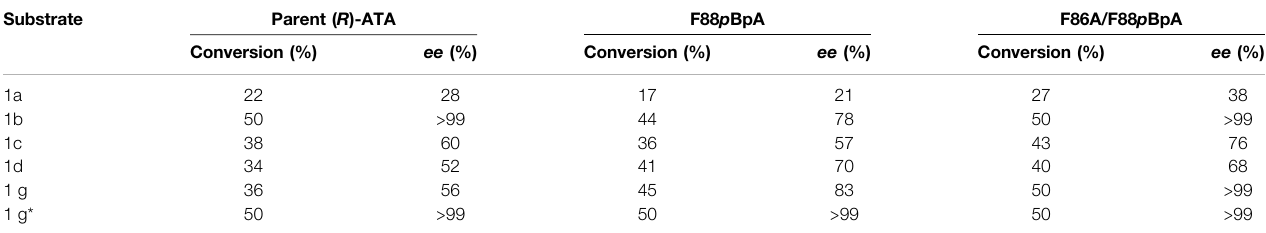
TABLE 1 | Kinetic resolution of various amine compounds using parent ( R )-ATA and its variants. Substrate Parent ( R )-ATA F88 p